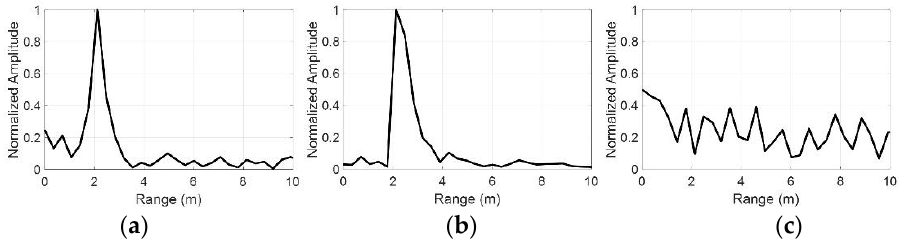
Figure 13. Compressed target echo as a function of the range: ( a ) laptop with linear scatterer ( b ) diode-terminated antenna with linear scatterer, and ( c ) only linear scatterers.